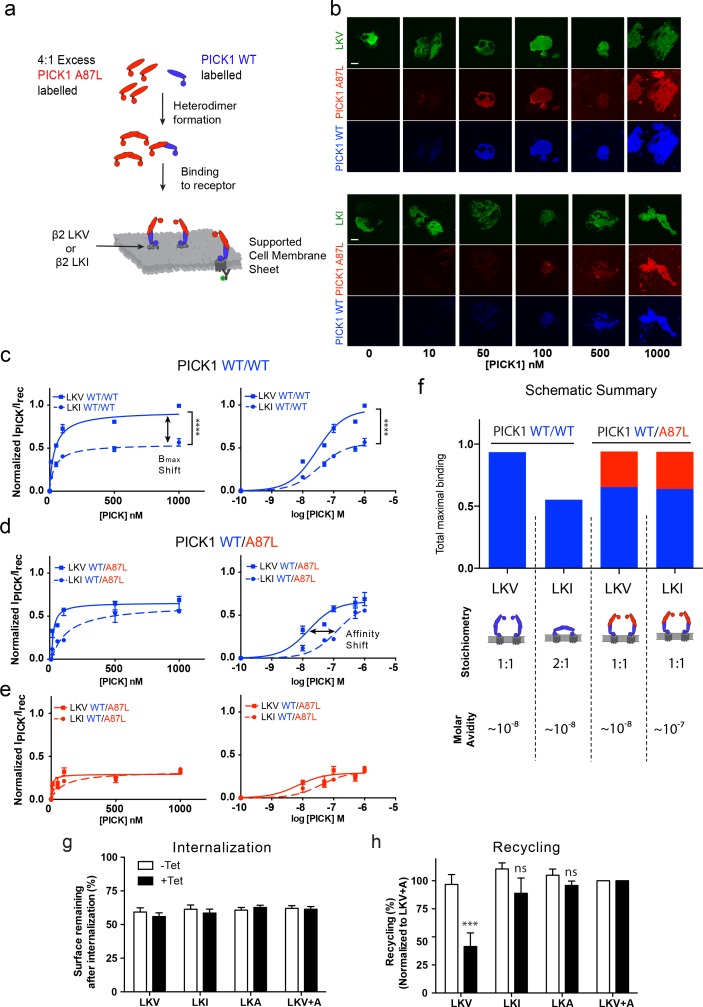
PICK1 switch scaffolding mode dependent on intrinsic PDZ affinity.(a) Schematic representation of the experimental setup. Both PICK1 WT (blue) and PICK1 A87L (red) are labeled. Exchange is allowed before binding of PICK1 WT/A87L heterodimers. (b) Representative images of heterodimeric binding as a function of concentration. (c–e) Normalized concentration dependent binding to either LKV (solid lines) or LKI (dashed lines), and quantified in both the WT (blue) and A87L (red) channel as function of linear and logarithmic concentration. LKV PICK1 WT/A87L: Kd*=24 ± 21 nM, Bmax: 51 ± 2%. LKI PICK1 WT/A87L Kd*=123 ± 21 nM, Bmax: 56 ± 2% (see Tables 1–3 for explanation of Bmax values) (n = 3), (****p≤0.0001). (f) Schematic summary of conclusions made from figures c-e. Fitted Bmax values are shown on the y-axis, for PICK1 WT/WT and PICK1 WT/A87L to SCMS expressing LKV and LKI together with avidity and proposed binding mode (g–h) Flp-In T-REx 293 eYFP-PICK1 cells transiently expressing LKV, LKI, LKA or LKV +A with (black bars;+Tet) and without (white bars; −Tet) tetracycline-induced expression of eYFP-PICK1 were surface-labeled with anti-FLAG M1 antibody prior to stimulation of internalization with agonist (10 μM Isoproteronol for 20 min). Subsequently, cells were treated with the antagonist (10 μM Alprenolol, 60 min) to allow recycling to the plasma membrane. Surface receptor immunoreactivity was determined by surface ELISA. Internalization (g) refers to the fractional reduction of surface receptor in response to 25 min of agonist exposure compared with non-treated cells (100%). Recycling (h) refers to the fractional recovery of surface receptor following antagonist incubation for 1 hr. These values were all normalized to the respective signal of non-interacting β2-LKV + A, with and without tetracycline induction, respectively. Data are means ±S.E, n = 6. (***p<0.001, ns >0.05, One way ANOVA, Bonferroni’s post test compared to LKV +A). Scale bars 10 μm.